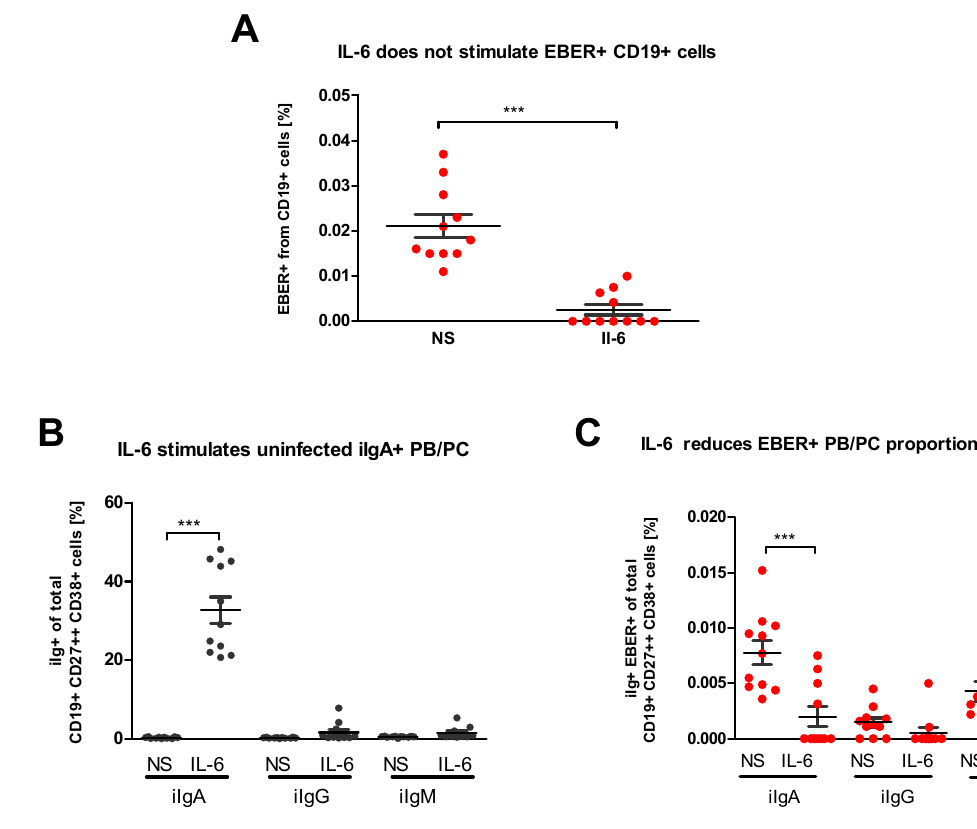
Fig. 6. Peripheral blood B cells response to IL-6.